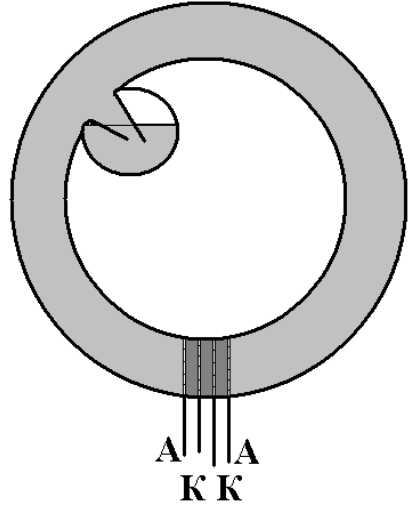
Figure 2. Molecular–electronic angular motion sensor design: A: anodes; K: cathodes of the sensor electrode transducer.